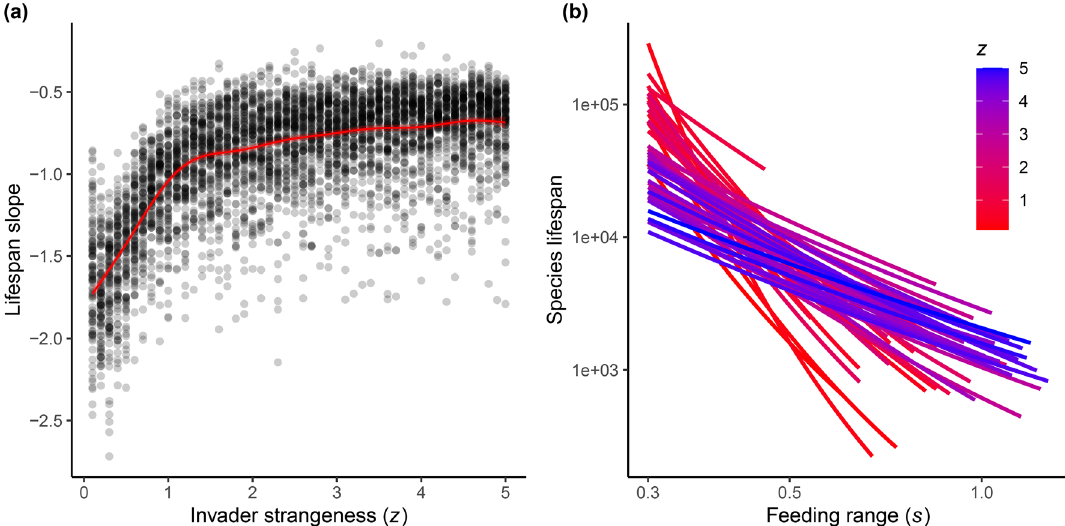
Figure 4. Species lifespan curves. ( a ) Shows the lifespan slope values for all simulations across the invader strangeness ( z ) sweep. Slope values are taken from the coefficients of generalized linear models (gamma error distribution and log link function) fit to the species lifespan by feeding range ( s ) data (log10-scaled) for all species in each individual simulation. The red regression line depicts the best-fit curve from our generalized additive model (GAM) to account for the observed non-linearity (identify error distribution and log link function). 95% confidence intervals shown by the shaded region around the regression line. ( b ) Shows lifespan slope curves from simulations across the invader strangeness value ( z ) for an example parameter sweep replicate. Regression lines are calculated for each individual simulation using generalized linear models with a gamma error distribution and log link